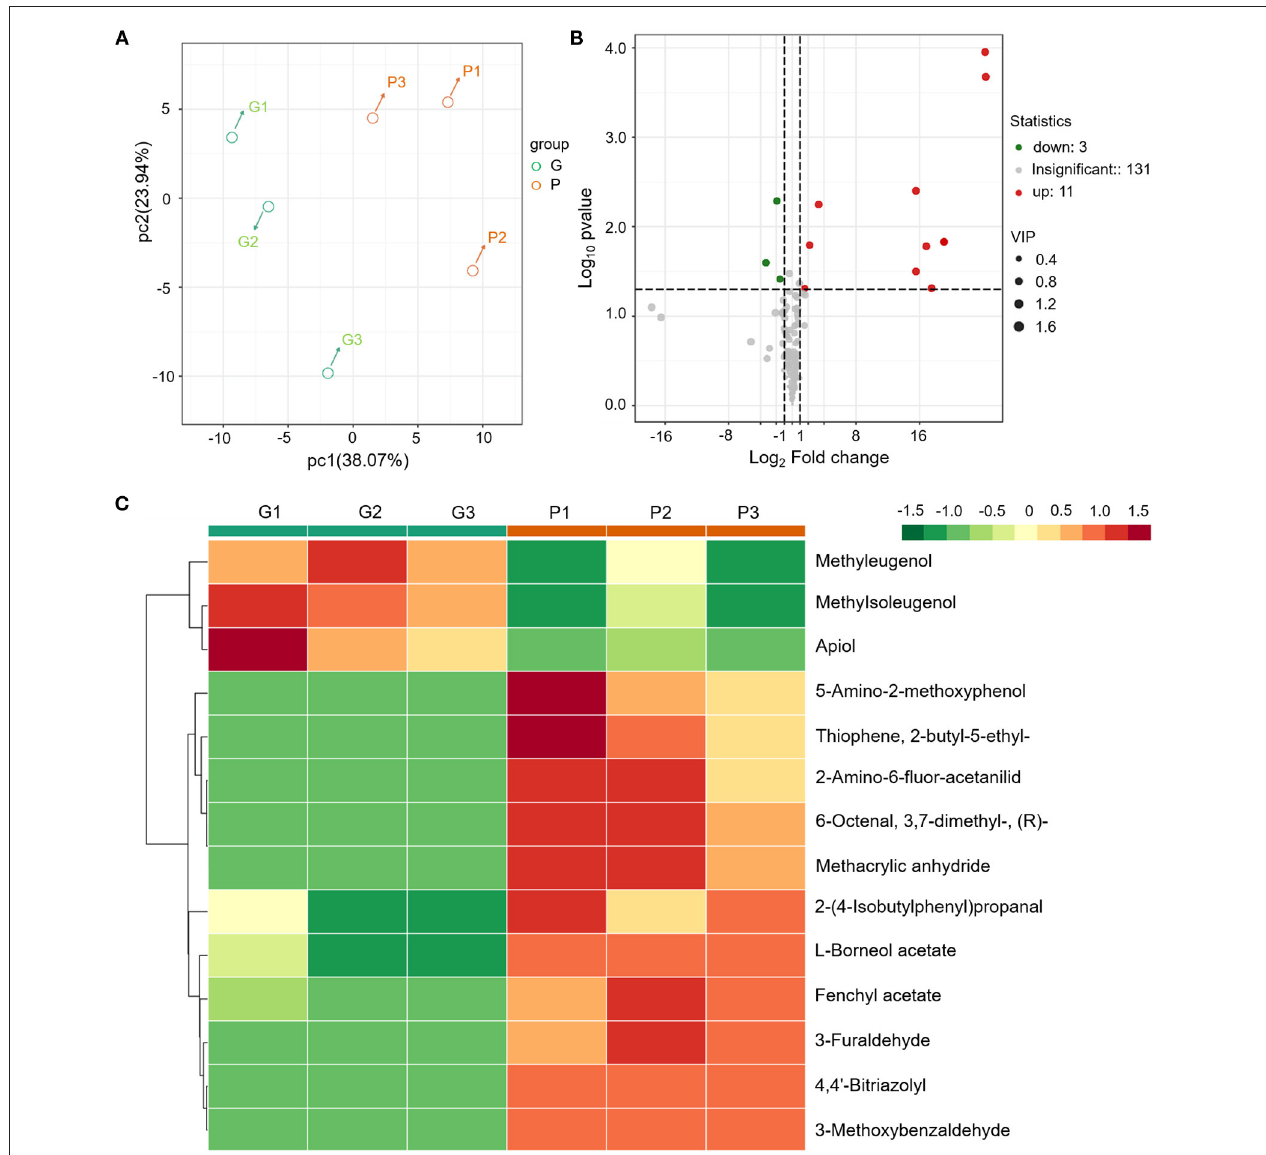
FIGURE 2 | Metabolomics analysis of the VOCs reveals the aroma changes in different fennel varieties (G vs. P). (A) PCA of the different samples. (B) Different VOCs were indicated by volcano plots. (C) Cluster heat map of the DAMs of different